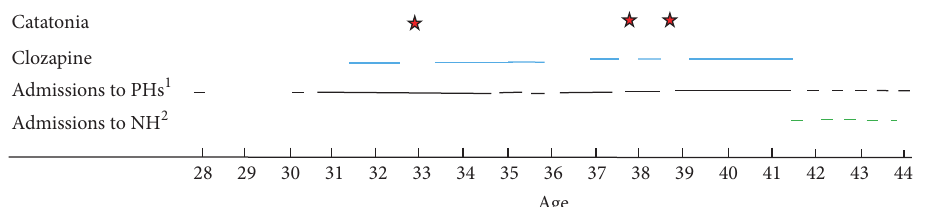
Figure2:Longitudinalcourseofourpatientincludingcatatonicepisodes,clozapinetrials,andadmissionstopsychiatricfacilities. 1 Psychiatric hospitals. 2 Nursing